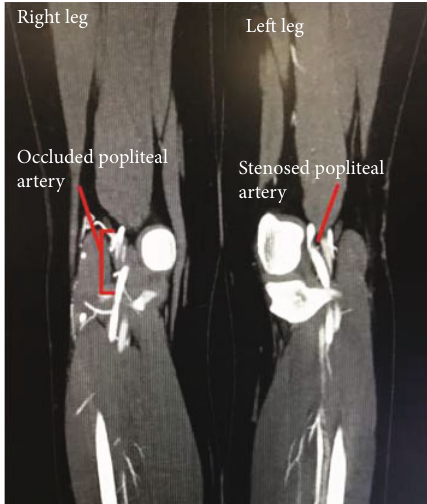
Figure 1: Computed tomography angiography demonstrating a coronal view of the behind knee popliteal arteries, with labelled total occlusion of the right popliteal artery and tight stenosis of the left popliteal artery.